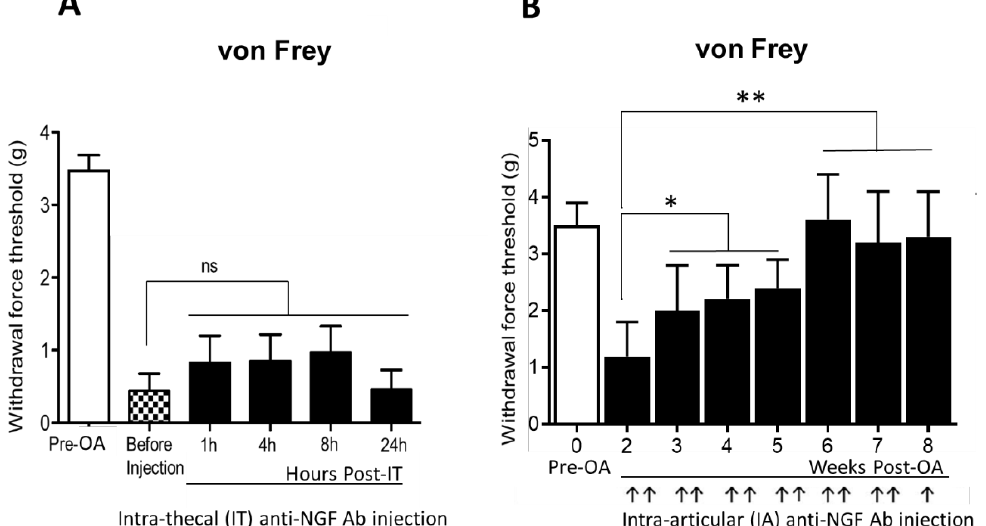
Figure 3. NGF/TrkA supported OA pain transmission in the peripheral but not in the central nerv- ous system. ( A ) Intrathecal (IT) injection of anti-NGF antibody in C57BL/6 mice at 13 weeks after PMM did not alleviate hyperalgesia from chronic osteoarthritis, indicating that pain transmission is not a central event but may occur through peripheral sensory neurons. OA was induced by partial medial meniscectomy (PMM) in 12-week-old wild-type C57Bl/6 mice ( n = 7), followed by pain test with von Frey filament. At 13 weeks after PMM, 10 µ g of anti-NGF antibody in 5 µ L (2 µ g/ µ L) was injected intrathecally, and pain was assessed at 1 h, 4 h, 8 h, and 24 h after IT injection. ( B ) Von Frey filament testing in the ipsilateral hindpaw of PKC δ null mice ( n = 10) receiving intaarticular (IA) injection of anti-NGF-2.5S antibody (30 µ g in 5 µ L saline) twice a week until 8 weeks after DMM surgery. Mice injected with anti-NGF antibody showed significantly reduced pain from the third week of anti-NGF IA injection. Black arrows indicate the IA injection. Adapted from Kc et al., Figure 6H [11]. * p < 0.05, ** p < 0.01, ns: not significant. p =